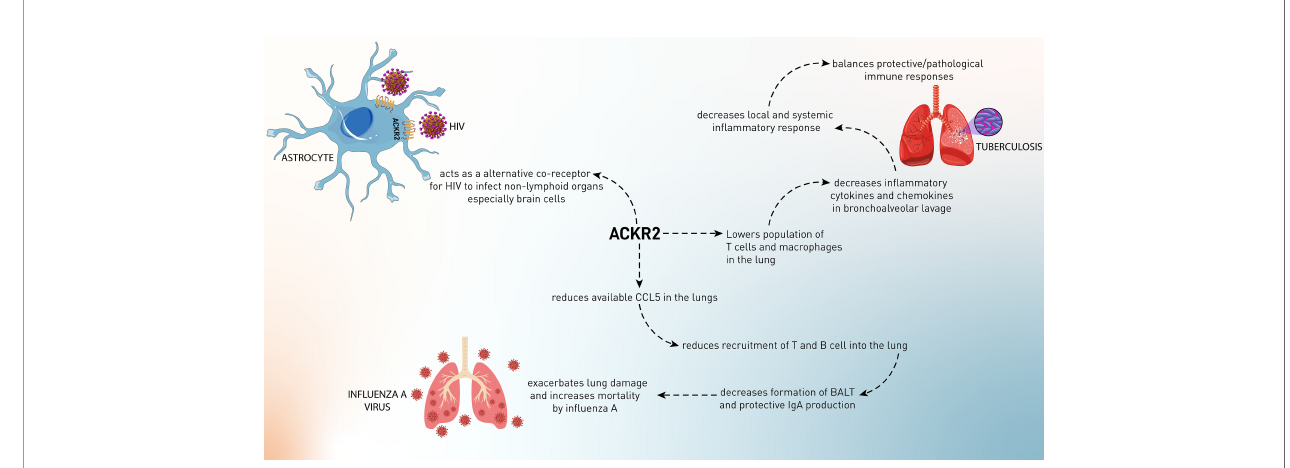
FIGURE 4 | The role of ACKR2 in infections including Mycobacterium tuberculosis , HIV, and in